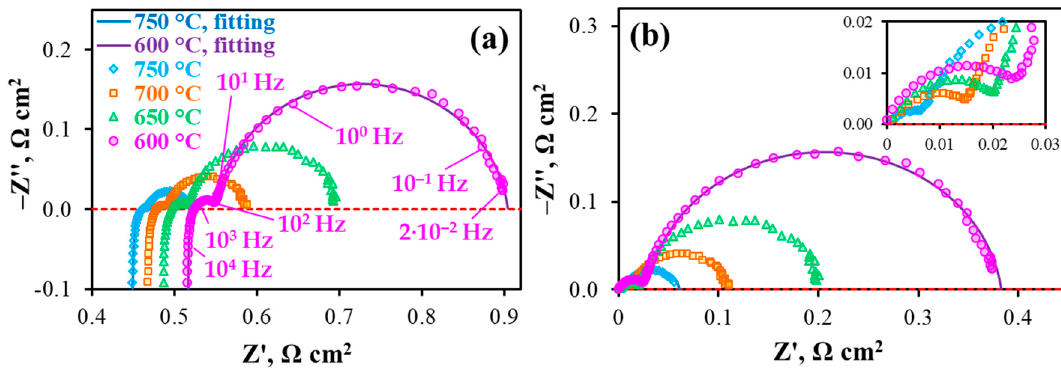
Figure 5. Impedance spectra of the PCC at different temperatures under 3%H 2 O/H 2 —3%H 2 O/air and OCV conditions: original spectra ( a ) and ones obtained after subtracting the ohmic resistance ( b ). According to the fitting procedure, the R O , R 1 , R 2 parameters, along with the polarization resistance of the electrodes (R p = R 1 + R 2 ) and total resistance of the PCC (R total = R O + R p ), were